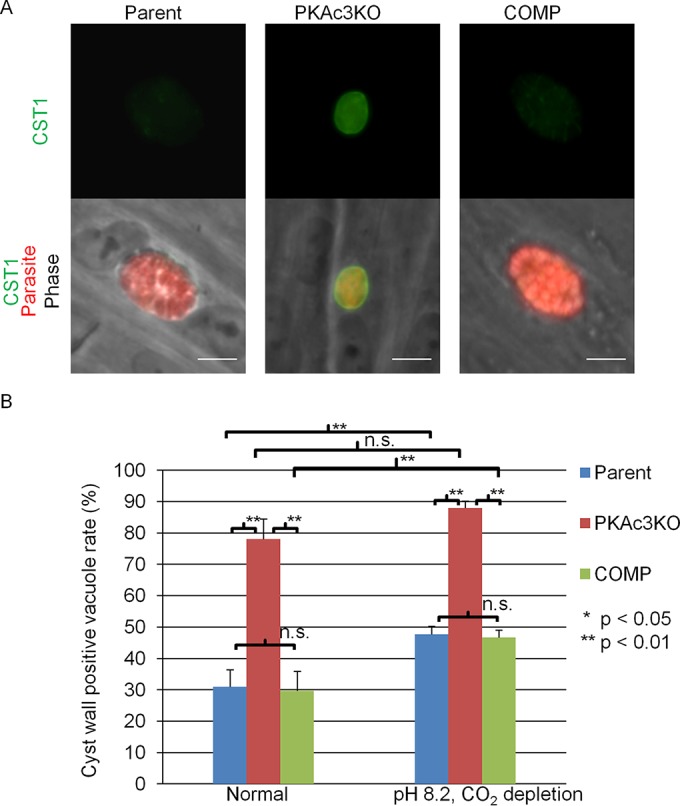
Disruption of TgPKAc3 induces bradyzoite-specific cyst wall formation. The cyst wall was stained to measure the bradyzoite differentiation status in the parental parasite PruΔku80Δhxgprt (Parent), knockout clone PruΔku80Δpkac3 (PKAc3KO), and complemented clone PruΔku80Δpkac3::PKAc3-3HA (COMP). Infected host cells were grown under normal culture conditions or bradyzoite induction conditions (pH 8.2 and CO2 depletion) for 48 h. Parasites were stained with anti-CST1 antibody (shown in green) or anti-Toxoplasma serum (shown in red). (A) Representative images of vacuoles with cyst walls (center panel, PruΔku80Δpkac3) and without cyst walls (left and right panels, showing PruΔku80Δhxgprt and PruΔku80Δpkac3::PKAc3-3HA, respectively) under tachyzoite culture condition. (B) Cyst wall-positive vacuoles were identified as parasitophorous vacuoles that have anti-CST1 signal associated with the parasitophorous vacuole. Quantitative measurements of the cyst wall-positive vacuole rate are shown. At least 100 total vacuoles per sample were counted, and cyst wall-positive vacuoles per total vacuoles are shown. Mean values and standard deviations from independent triplicate experiments are shown. If one-way analysis of variance detected significant differences among the group, Tukey’s honestly significant difference test results are shown. *, P < 0.05; **, P < 0.01; n.s., nonsignificant.